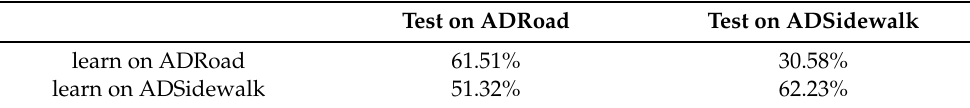
Table 2. mIoU results of cross-validation test between the first part of the additional dataset: ADRoad (images taken from a viewpoint located on the road), and the second part: ADSidewalk (same images but taken from a viewpoint located on the